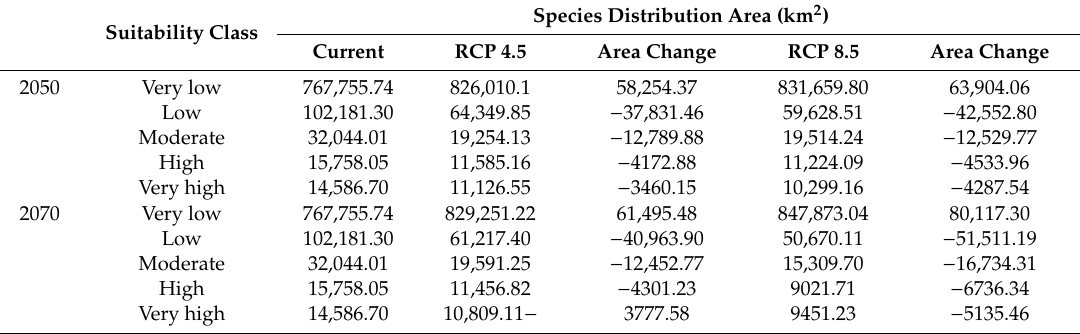
Table 4. Change in suitable areas of P. africana country-wide for mid-century and late-century under representative concertation pathway (RCP) 4.5 and RCP 8.5